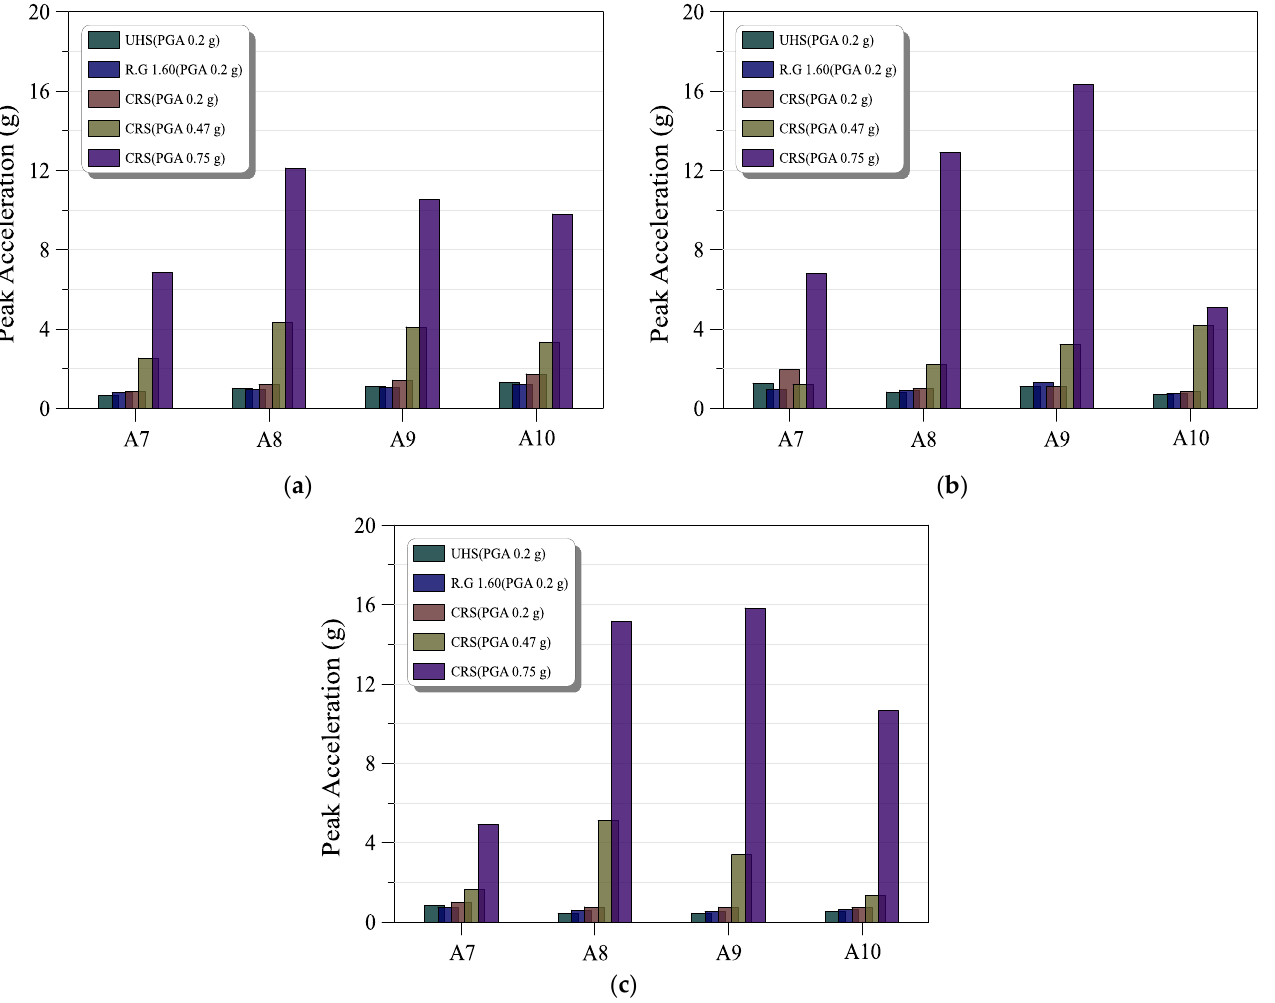
Figure 12. Comparison of in-cabinet peak acceleration depending on input motion: ( a ) side to side, ( b ) front to back, and ( c ) vertical.